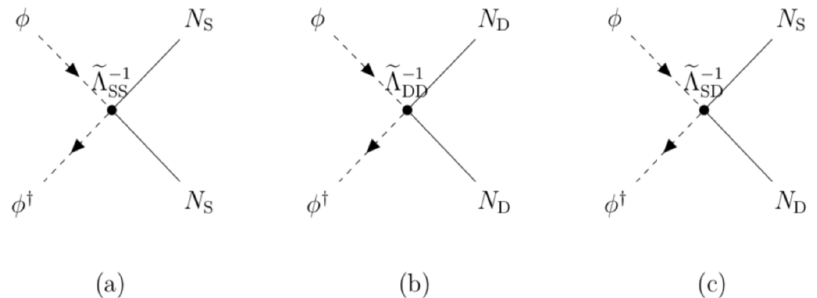
Figure 3 . Higgs portal interactions: source neutrino production (a), dark neutrino production (b) and mixed production